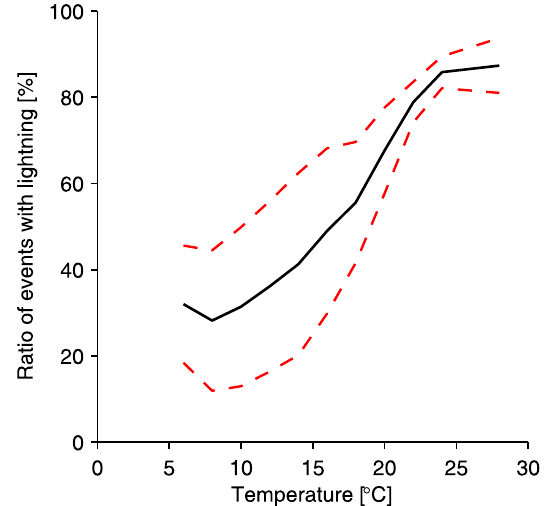
Figure 10. The average percentage of lightning events in the set of all events as a function of air temperature for the 59 studied stations. Red lines give bounds ± 1 standard